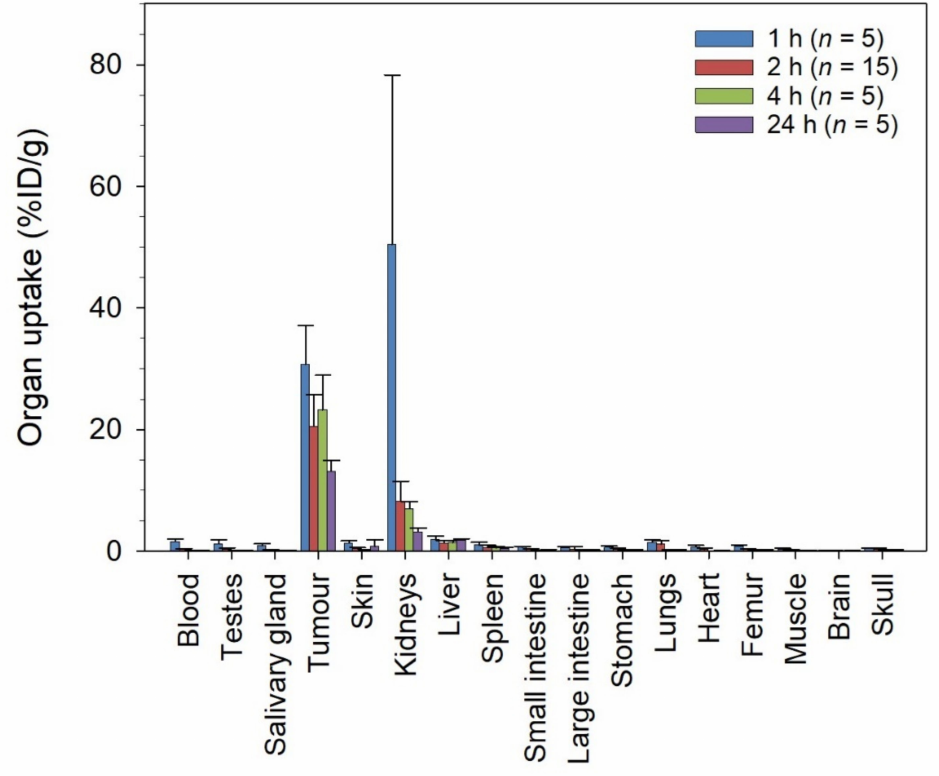
Figure 2. Uptake (percent of injected dose per gram of tissue, %ID/g) of 212 Pb-NG001 in nude mice bearing human prostate PC-3 PIP xenografts at various time points after administration. n , number of mice per